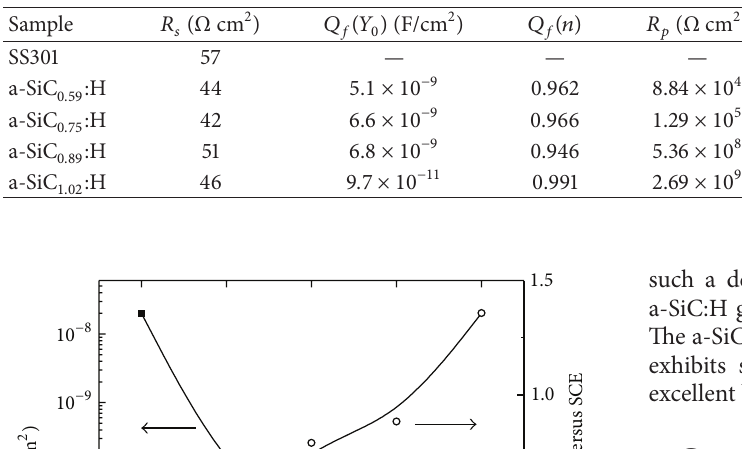
Table 2: The best-fit values of EIS spectra of SS301 and a-SiC 𝑥 :H samples.